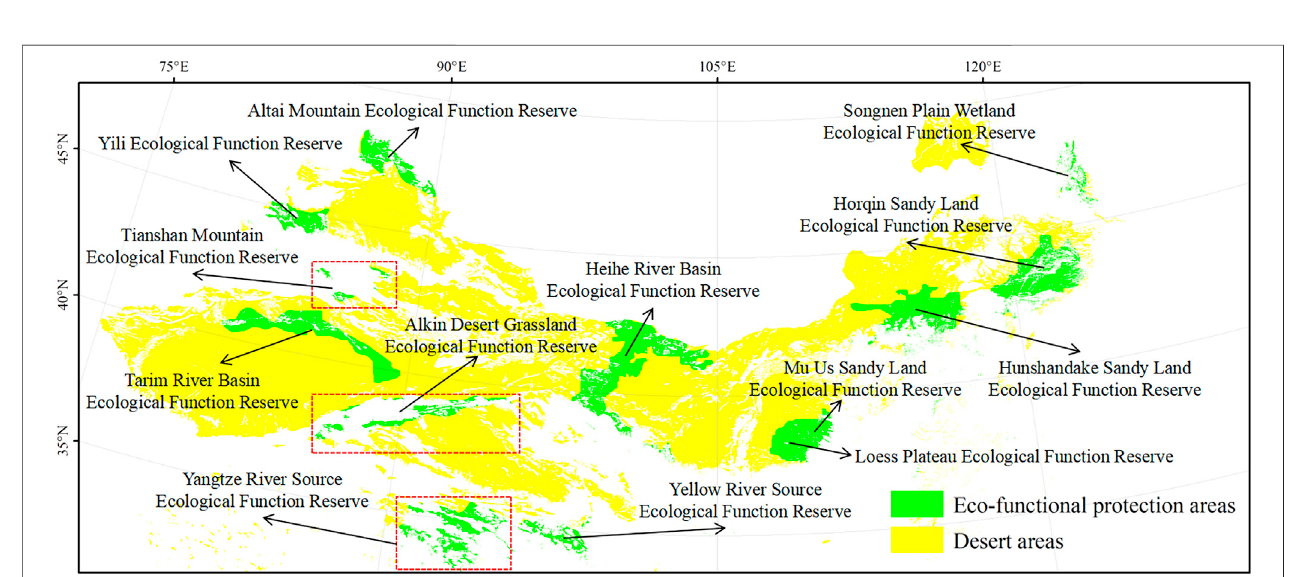
FIGURE 11 | The Ecological Function Reserves that have been established in northern China ’ s desert areas.